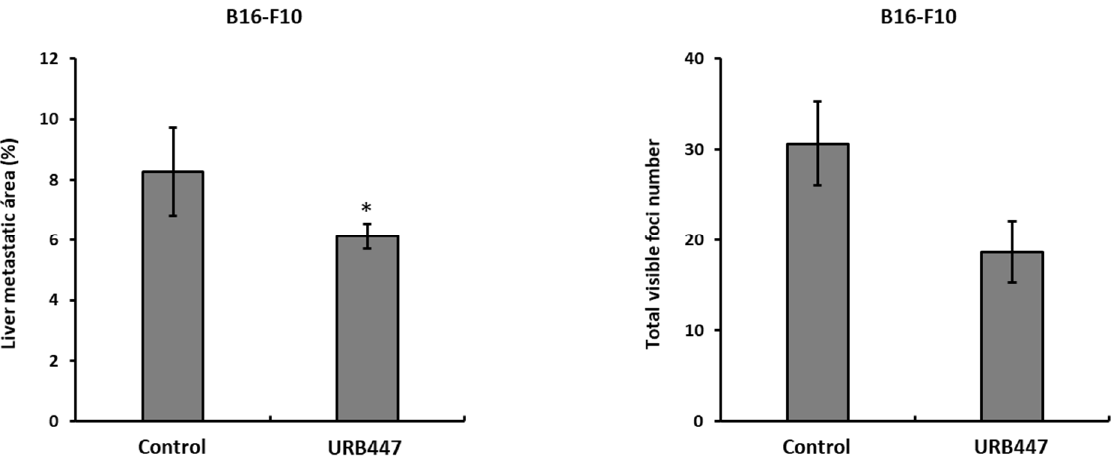
Figure 7. Metastatic growth of melanoma in control and URB447 treated mice liver. Mice were intrasplenically injected with 2 × 10 5 B16-F10 melanoma cells and treated with Vehicle or URB447 1 mg/kg for 10 days. The metastatic area and visible foci number were quantified. ( n = 4). Differences were considered statistically significant for * p < 0.05 using Student t test.